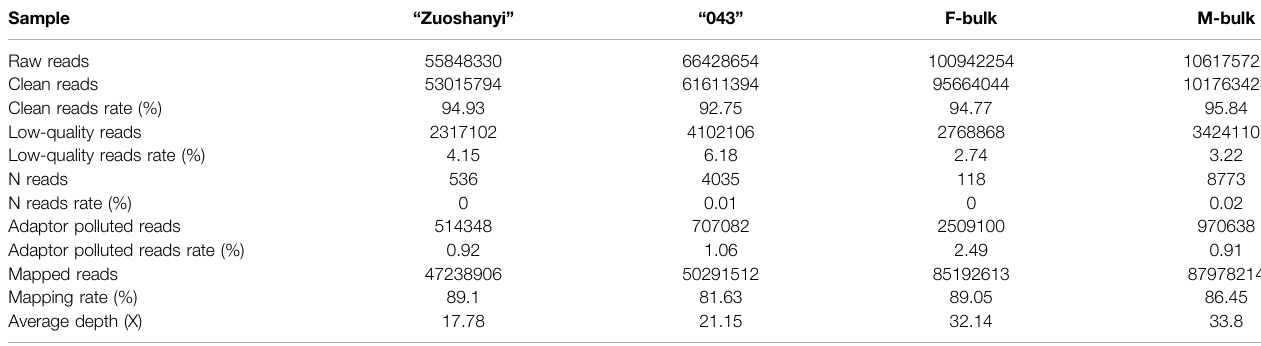
TABLE 1 | Statistics of sequencing